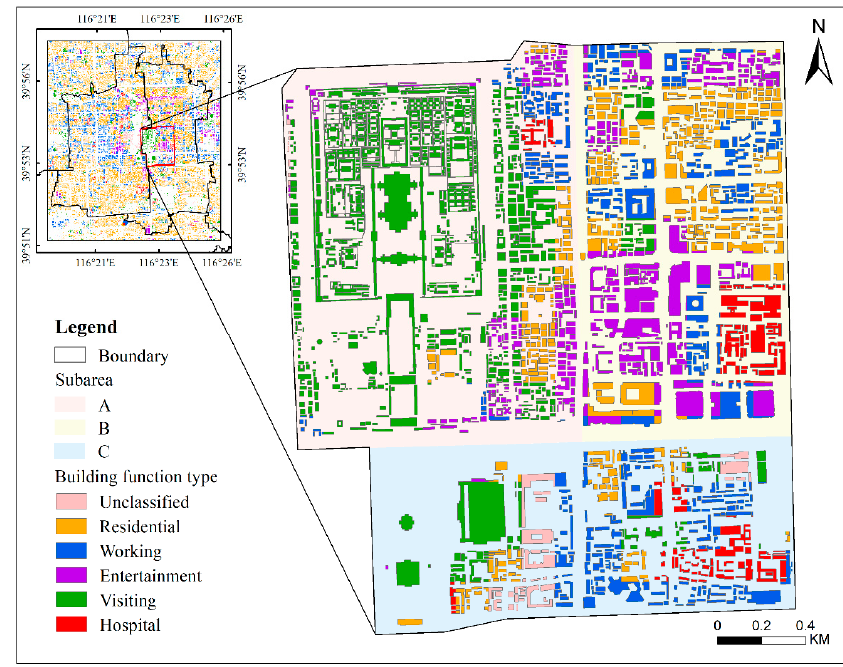
Figure 18. BFT map of Donghuamen Street predicted using the constructed RF models.